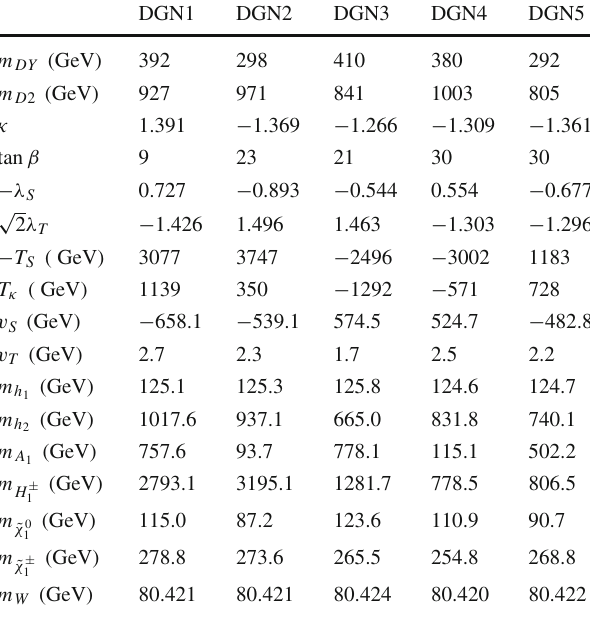
Table3 Benchmarkpointsforthe“alignedDGNMSSM”.Inputparam- eters are given above the double line, and masses of the most important particles below A-DGN1 A-DGN2